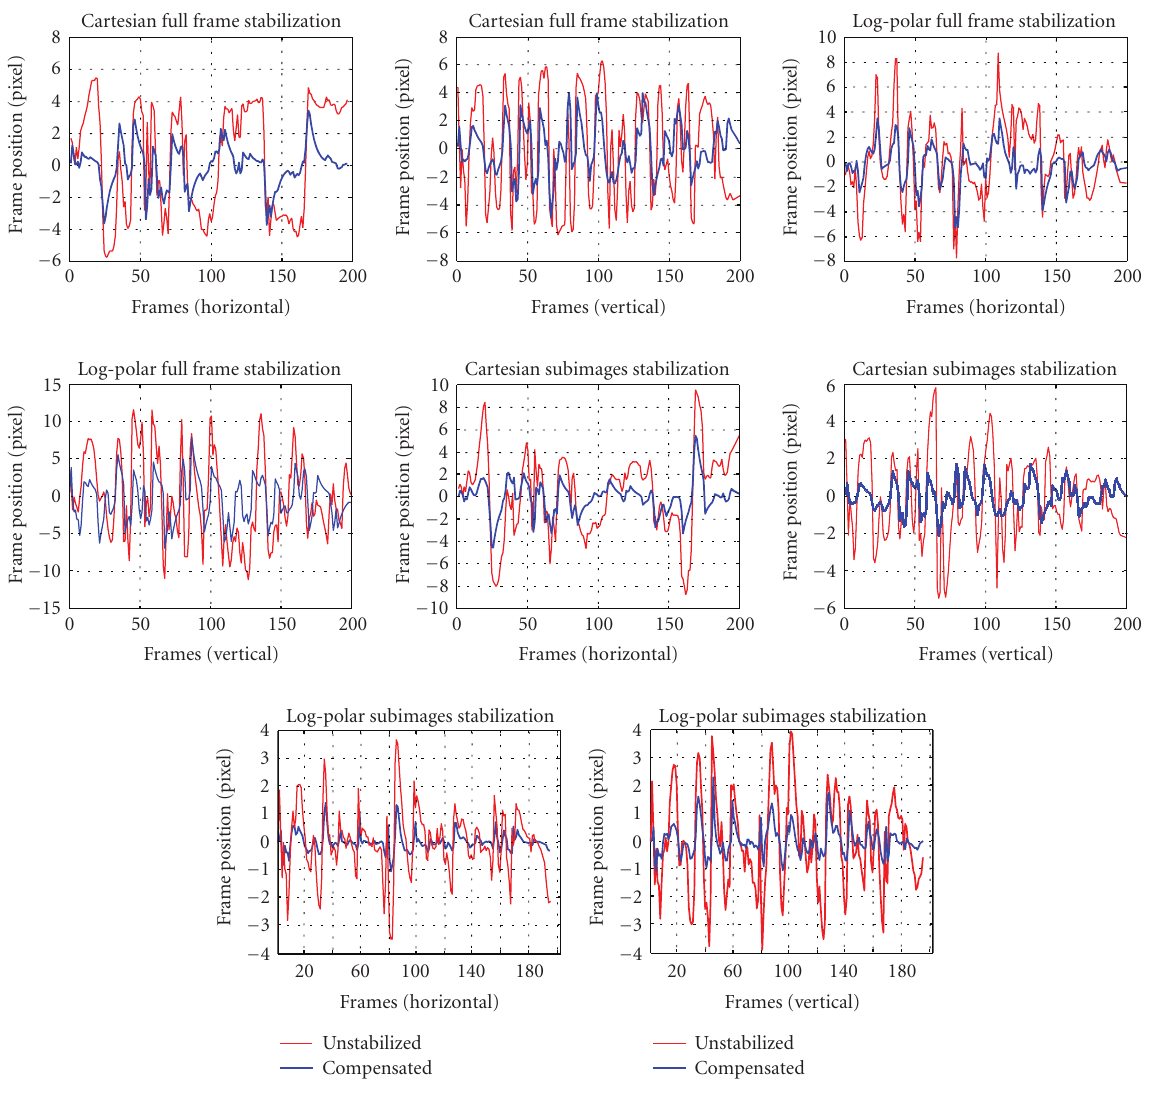
Figure 7: The absolute frame positions before and after the stabilization for all the tested